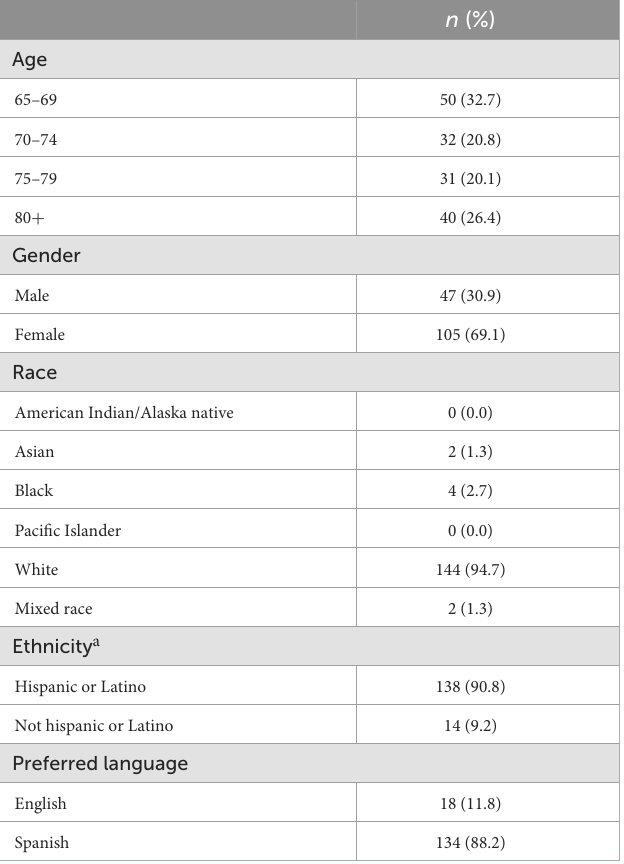
TABLE 4 PEARLS participant demographics ( N =